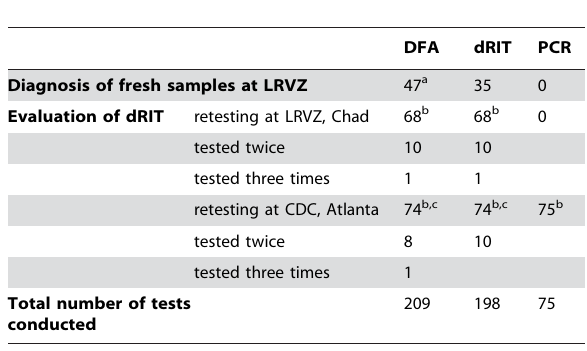
Table 1. Number of samples tested by different methods